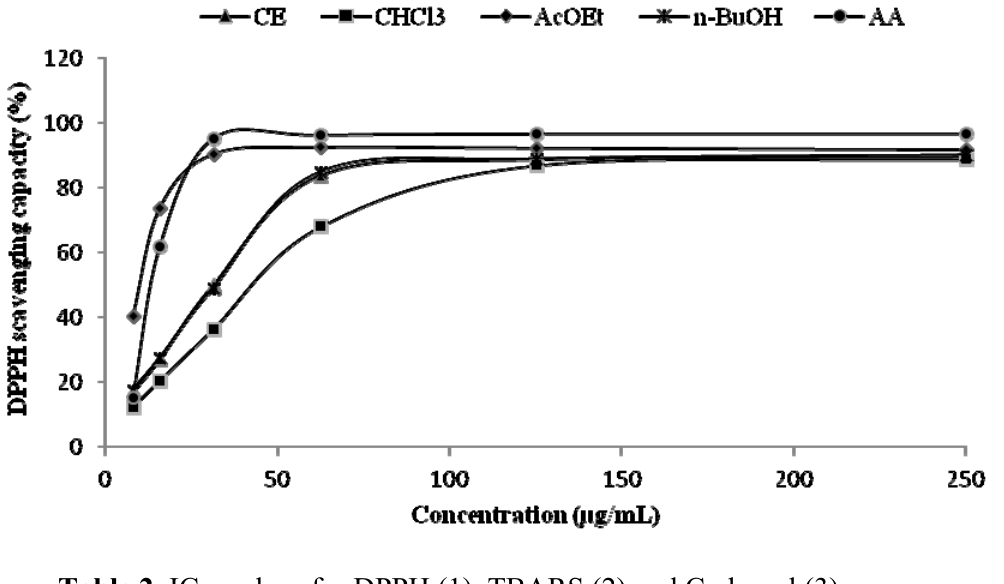
values for DPPH (1), TBARS (2) and Carbonyl (3) Table 2. IC 50